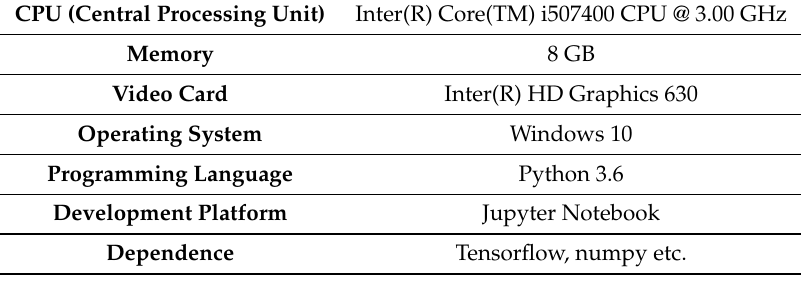
Table 1. The environment of all experiments.